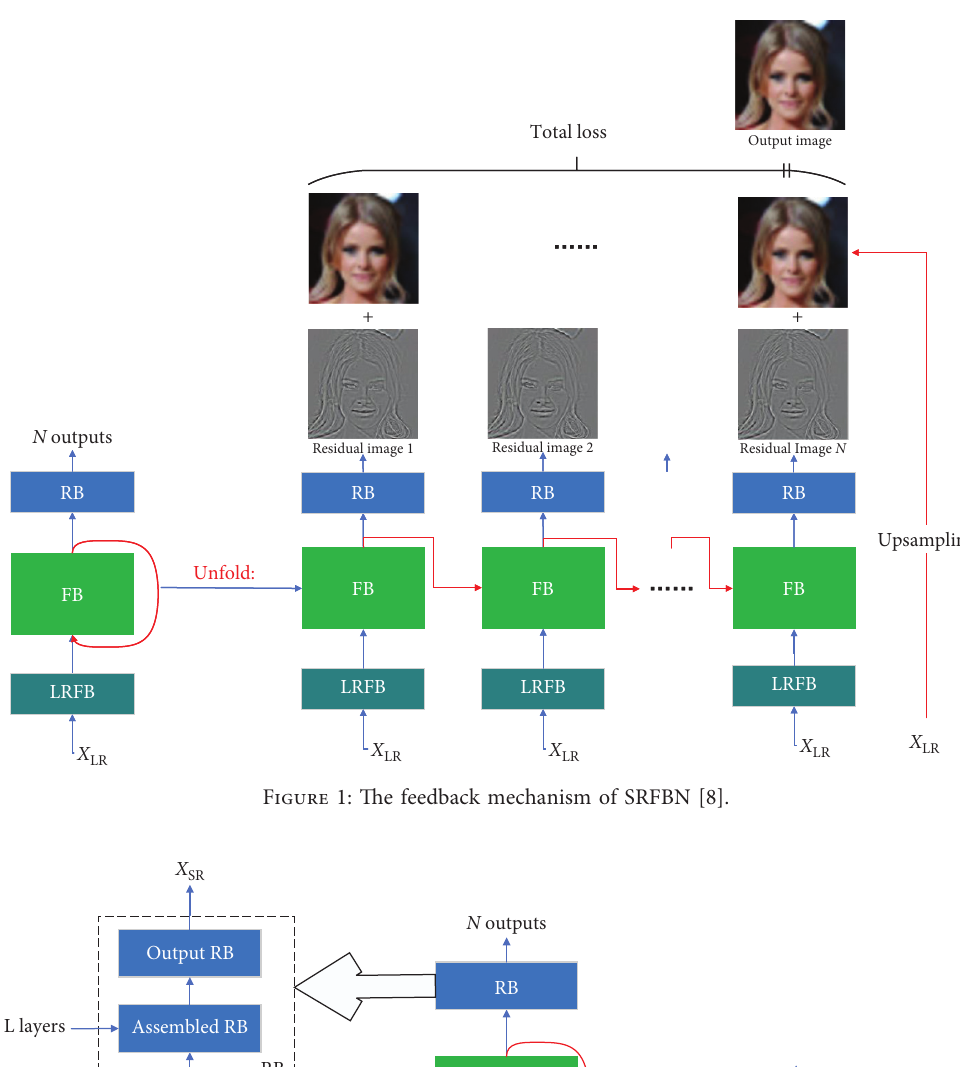
Figure 1: The feedback mechanism of SRFBN